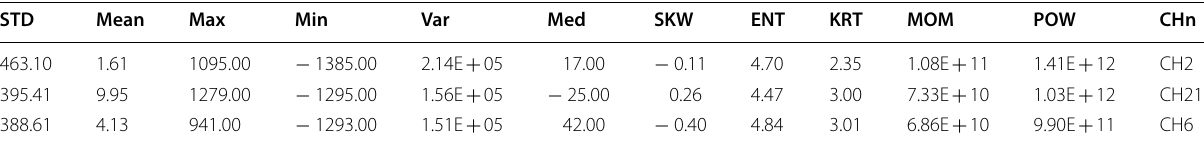
Table 2 Extracted features of selected channels STD